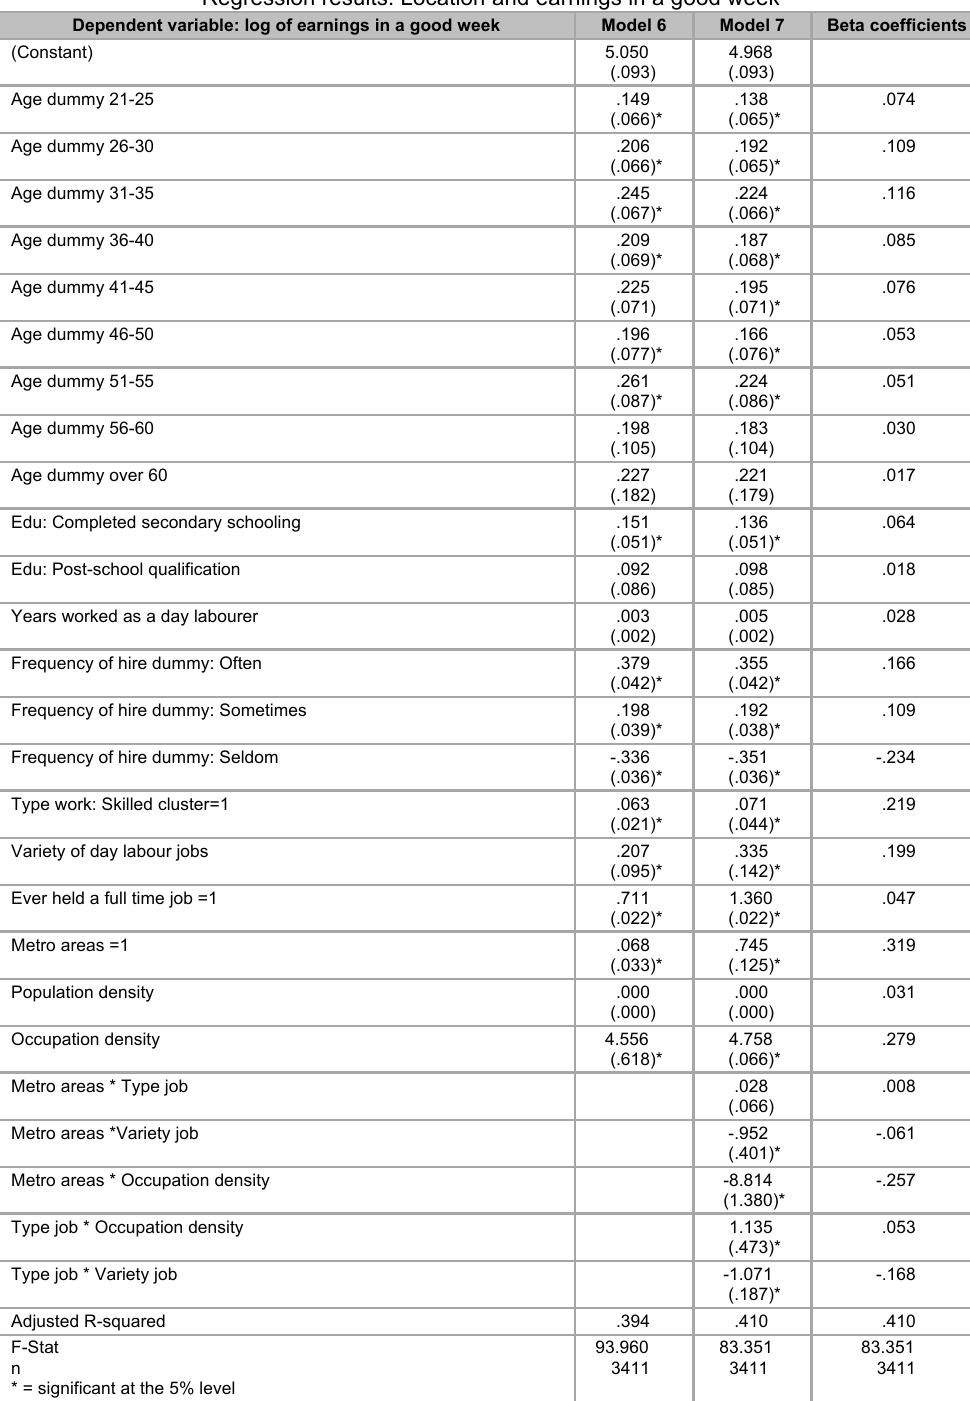
Regression results: Location and earnings in a good